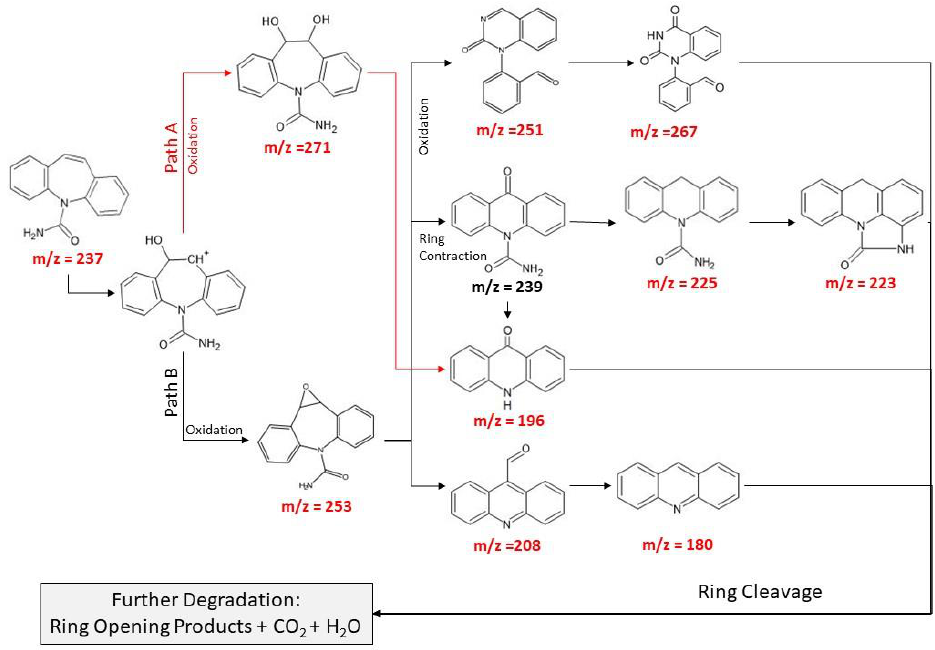
Figure 13. Proposed degradation pathways of CBZ using MIL-101(Cr)@TiO 2 under UV-A irradia-